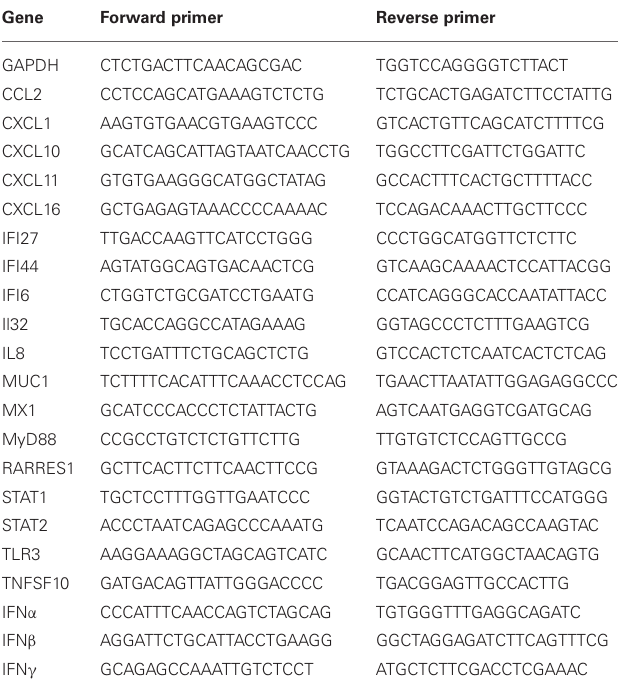
Table 2 | Primer sequences used for qRT-PCR based validation of microarray results.